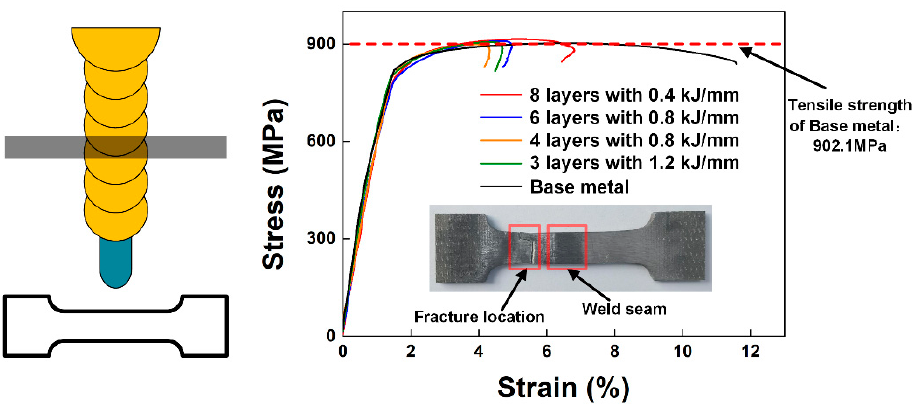
Figure 8. Tensile test results of the filling layer.